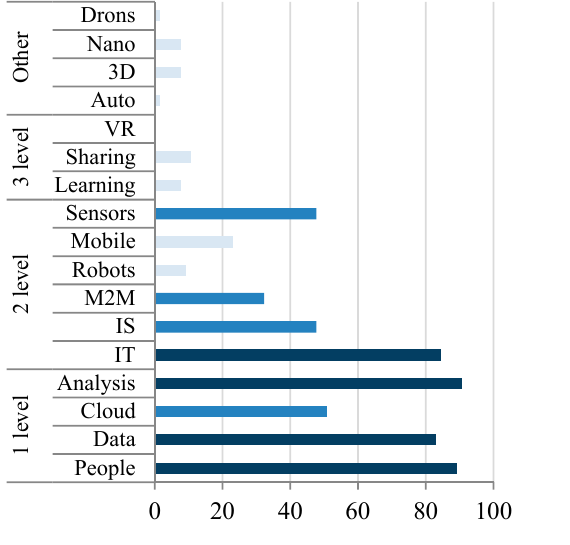
Table 5. Results of ANOVA test.